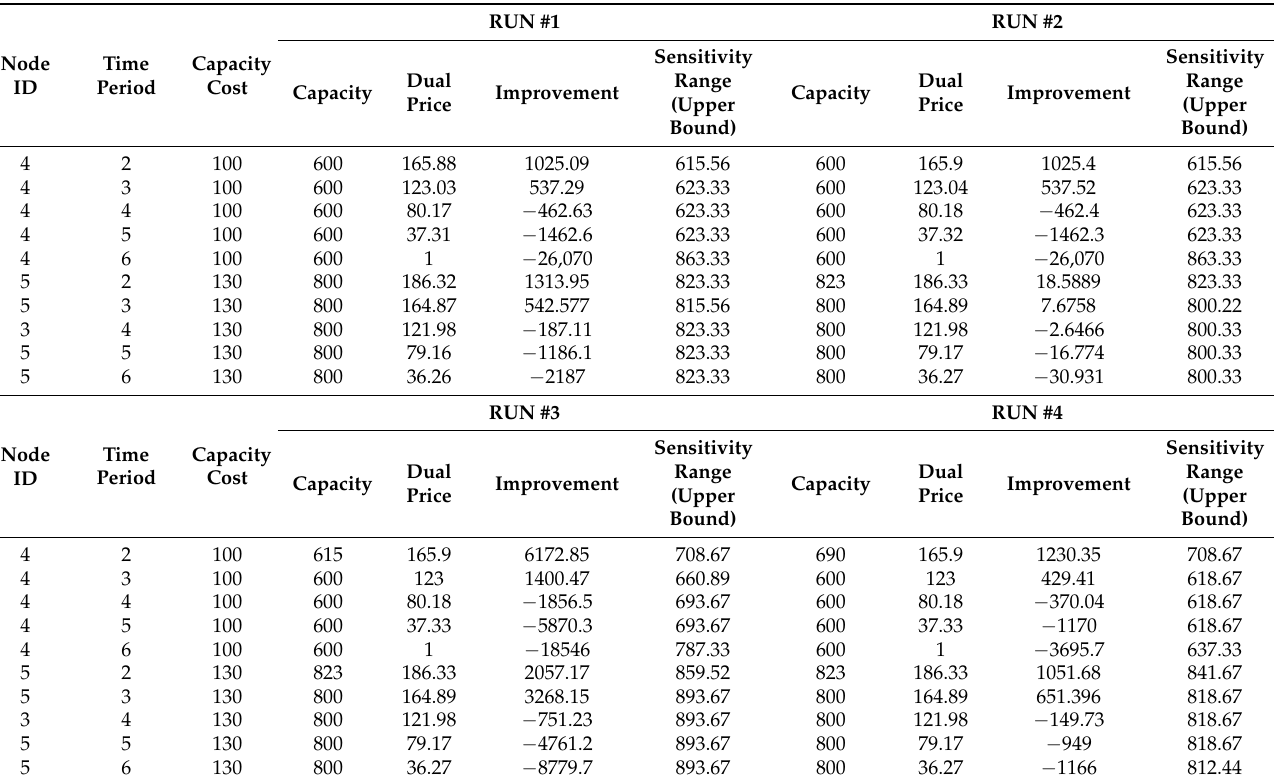
Table 7. A Summary of four runs of the bottleneck alleviation